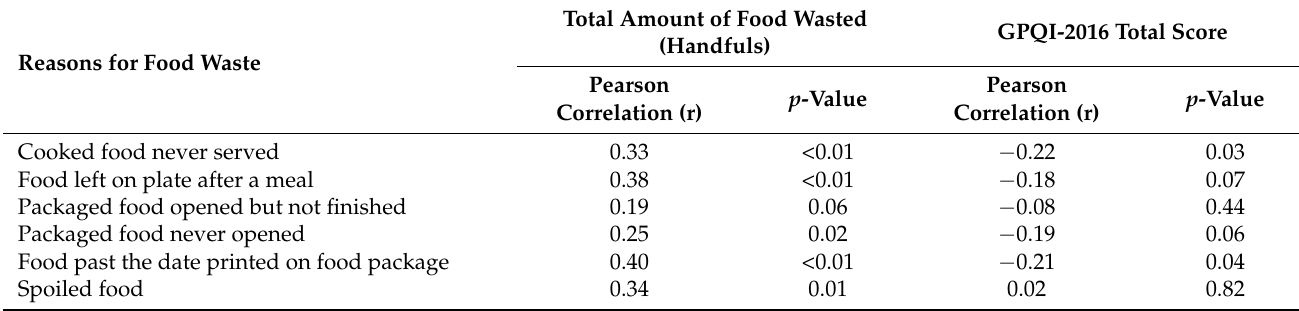
Table 5. Point-biserial correlation between reasons for food waste and diet quality of foods purchased (GPQI-2016 total score) and total amount of food wasted (handfuls).